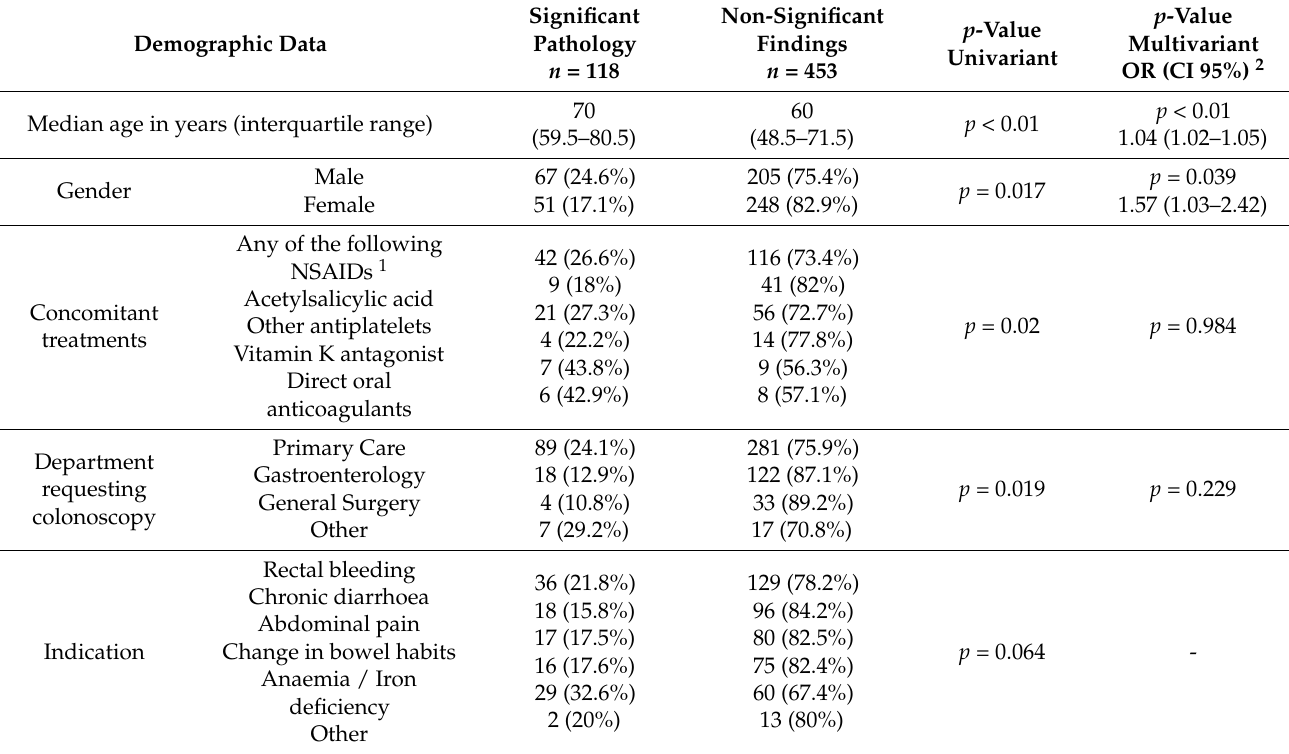
Table 1. Baseline demographic data and their association with significant